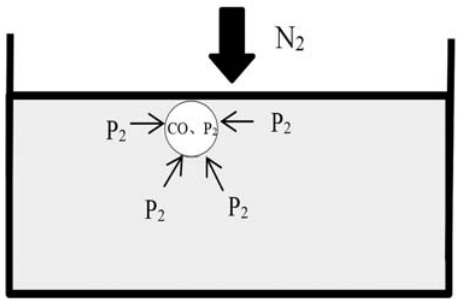
Figure 7: CO bubbles equilibrated with P 2 at the